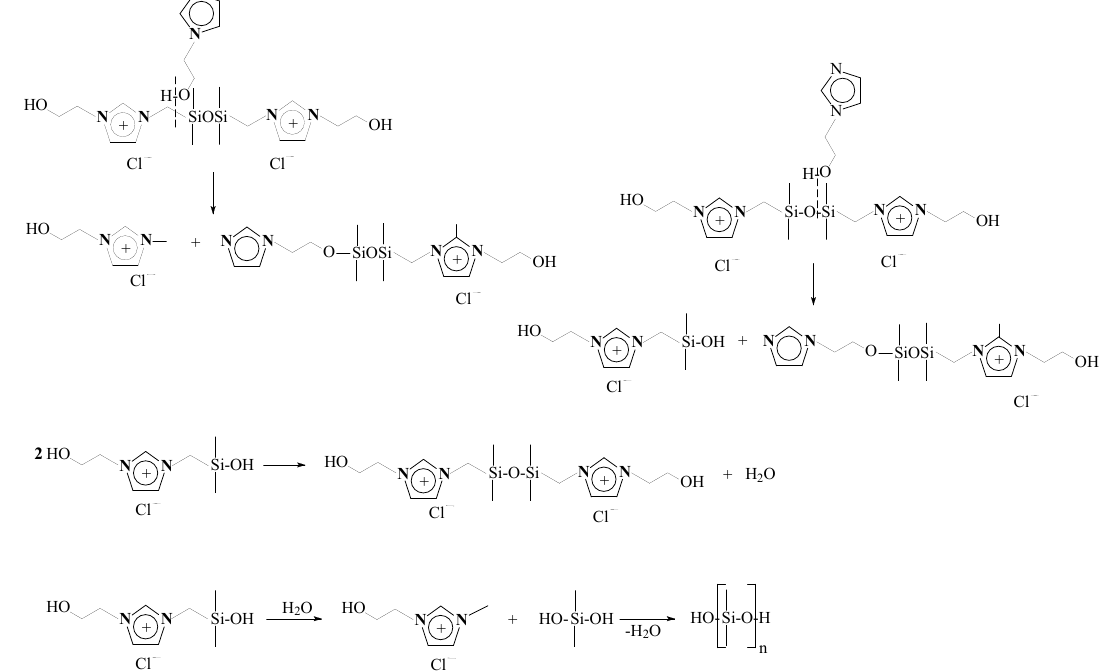
Scheme 6. Protolysis side-reactions leading to impossibility of direct synthesis of ILs 7 and 9.